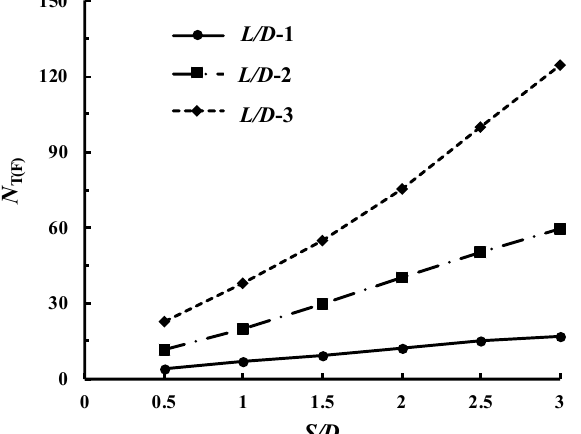
Figure 12. Torsional dimensionless load with L / D and S / D ratios.